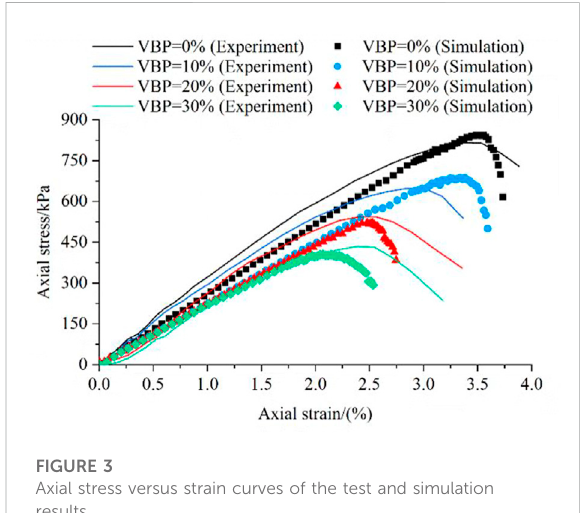
FIGURE 3 Axial stress versus strain curves of the test and simulation results.